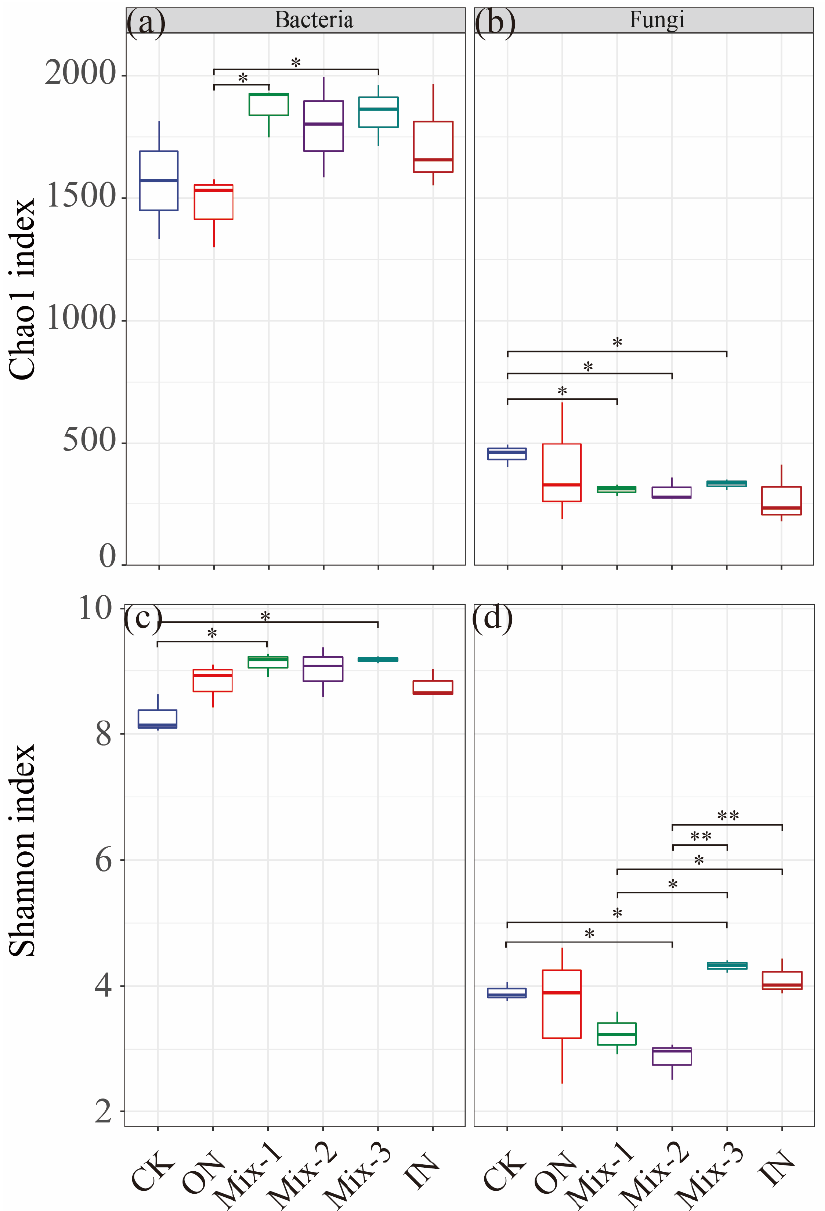
Figure 1. The alpha diversity of bacteria ( a , c ) and fungi ( b , d ) in different treatments. * p < 0.05 and ** p <